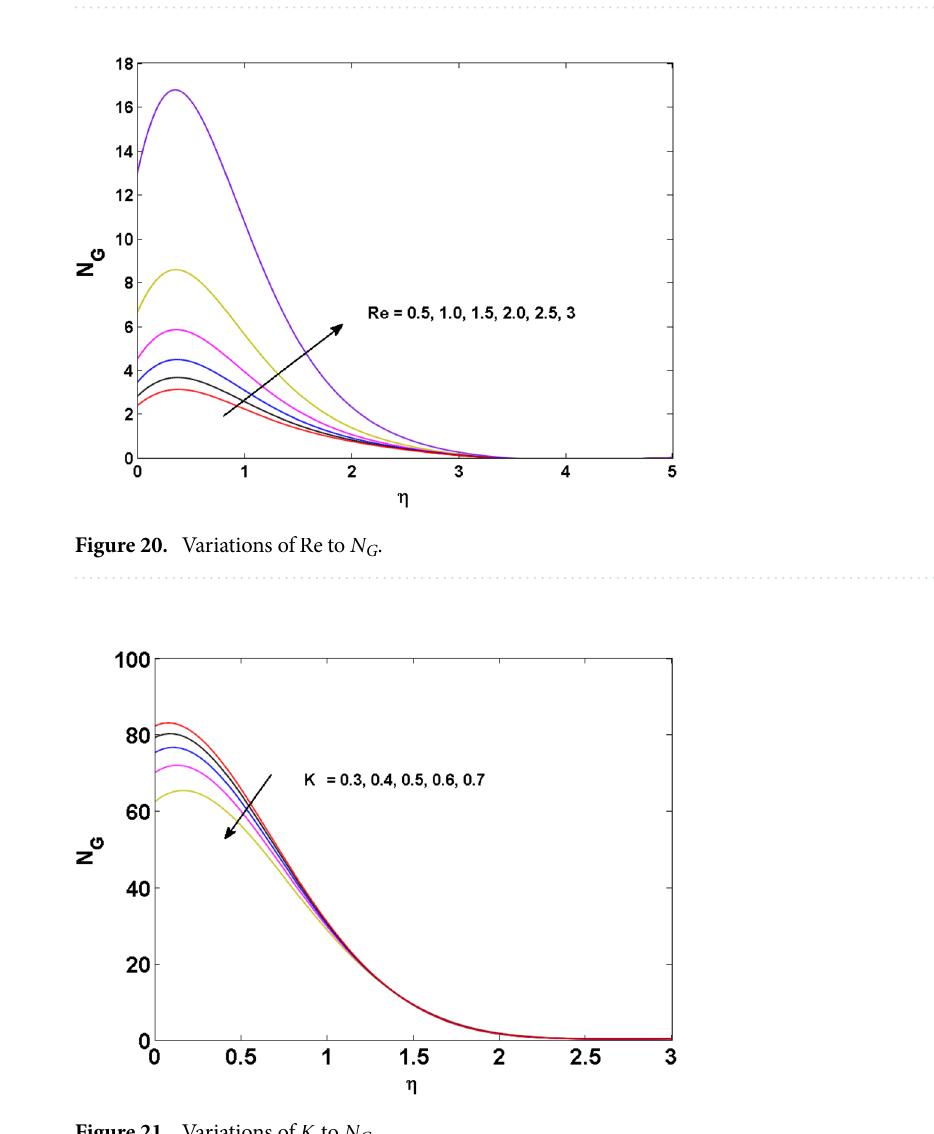
Figure 19. Variations of (cid:31) 2 to N G .